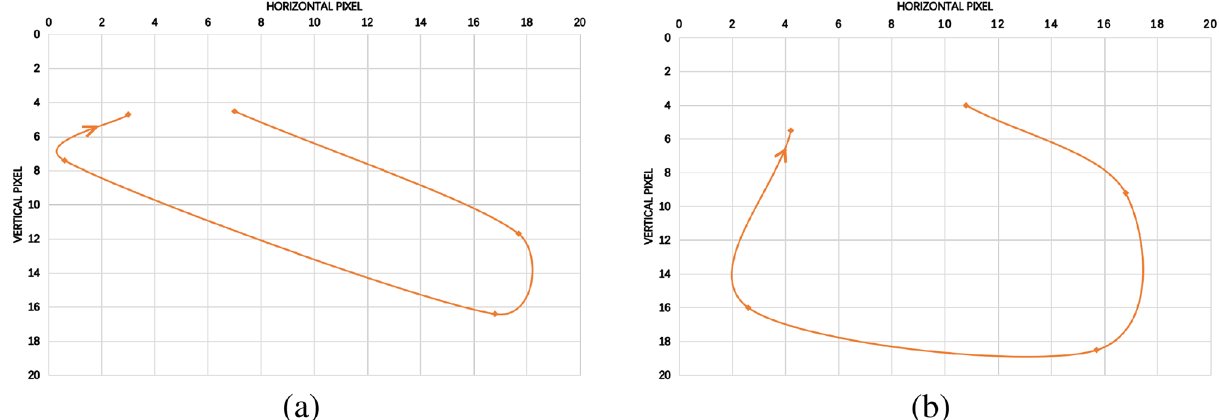
Figure 8. Clockwise circle movement trajectory. ( a ) Traditional clustering algorithms, ( b ) proposed clustering algorithm.